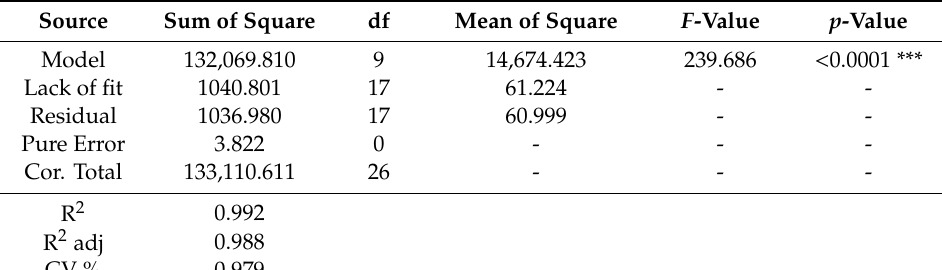
Table 5. ANOVA of the predicted model for used for UAE of TFC from N. lotus stamens. Source Sum of Square df Mean of Square F -Value p -Value Model 132,069.810 9 14,674.423 239.686 < 0.0001 *** Lack of fit 1040.801 17 61.224 Residual 1036.980 Pure Error 3.822 Cor. Total 133,110.611 26 - - - R 2 0.992 R 2 adj 0.988 CV %